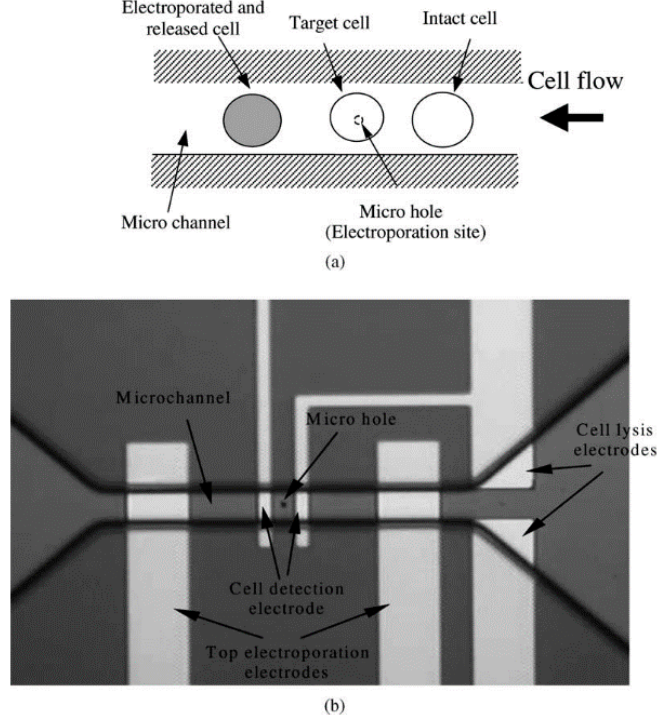
Figure 8. ( a ) Principle of flow through the micro-electroporation chip ( b ) Layout image of micro-hole, micro-channel, and integrated electrodes. Reprinted with permission from ref. [107]. Copyright © 2003 Elsevier.